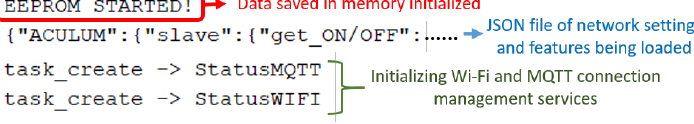
Figure 11. CSFs running on ACU-LUM.